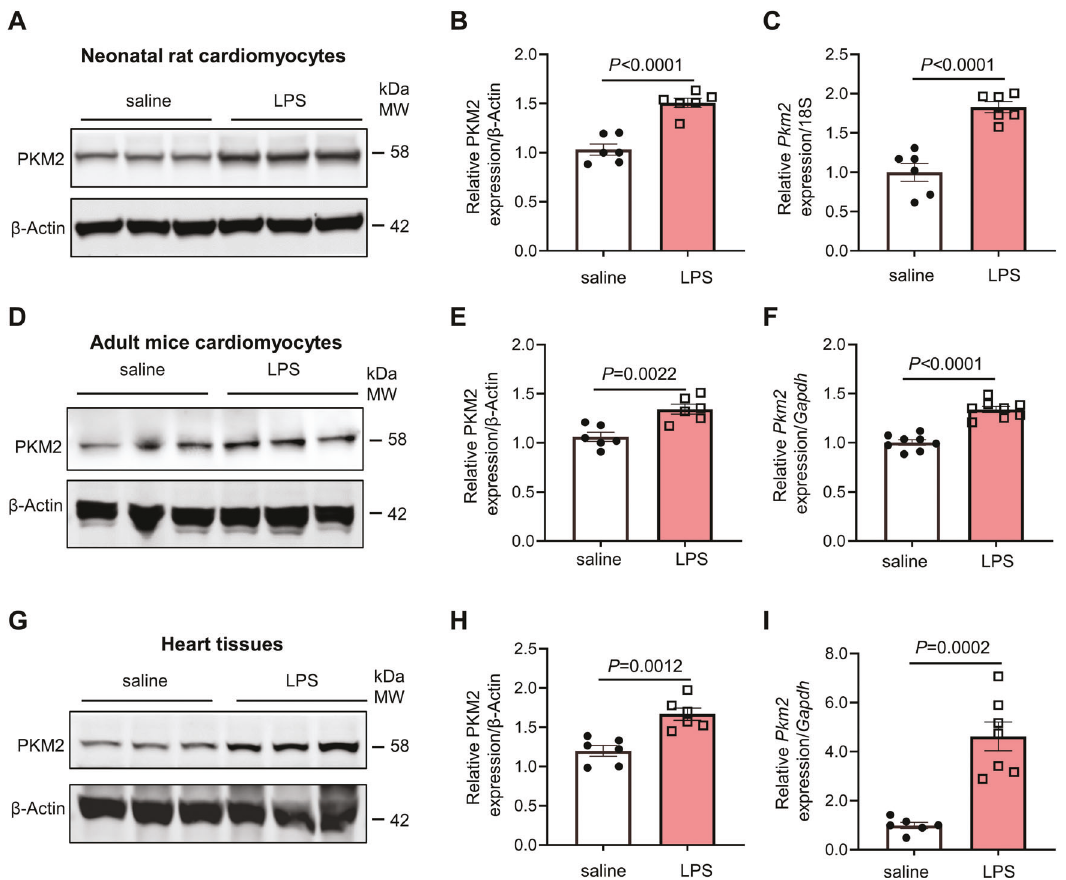
Fig. 1 PKM2 expression increased in cardiomyocytes in response to lipopolysaccharide (LPS). A , B Western blot and quanti fi cation of PKM2 expression in neonatal rat cardiomyocytes (NRCMs) with saline or LPS administration for 24 h. β -Actin served as loading control, n = 6. C Quantitative real-time polymerase chain reaction (qRT-PCR) analysis of Pkm2 in NRCMs administrated with LPS. 18S was used as an internal reference gene, n = 6. D , E Western blot and quanti fi cation of cardiac PKM2 expression in AMCMs administrated with saline or LPS for 24 h. β -Actin served as loading control, n = 6. F qRT-PCR analysis of Pkm2 in AMCMs administrated with LPS. Gapdh was used as an internal reference gene, n = 8. G , H Western blot and quanti fi cation of cardiac PKM2 expression in myocardial tissues. β -Actin served as loading control, n = 6. I qRT-PCR analysis of Pkm2 in myocardial tissues. Gapdh was used as an internal reference gene, n = 6 to 7. Values represent the mean ± SEM of at least three independent